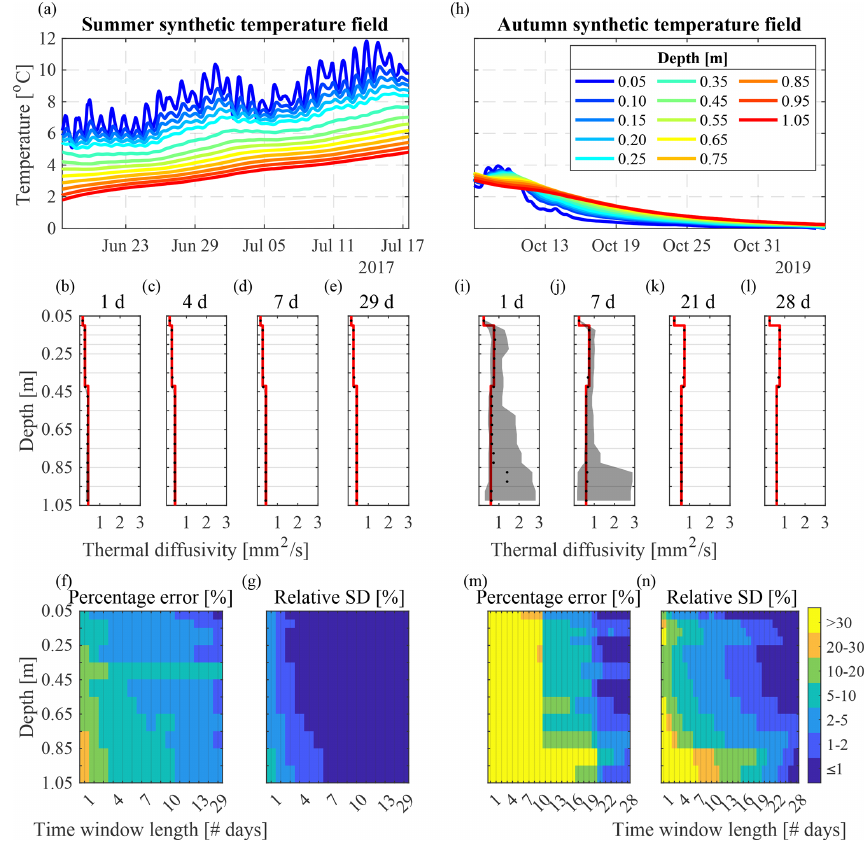
Figure 1. Synthetic temperature field for (a) summer and (h) autumn and corresponding MCMC inversion results for (b–g) summer and (i– n) autumn. (b–e , i–l) Median (black dots) and range (black shaded areas) of the posterior means of thermal diffusivity at each depth derived from MCMC simulation for various sliding time window lengths. Red lines show the “true” thermal diffusivity profile. (f–g , m–n) Percentage error (Eq. (7)) and posterior relative standard deviation (Eq. 8) at each depth for sliding time windows of different lengths ( x axis). Note that the time window length in the x axis is